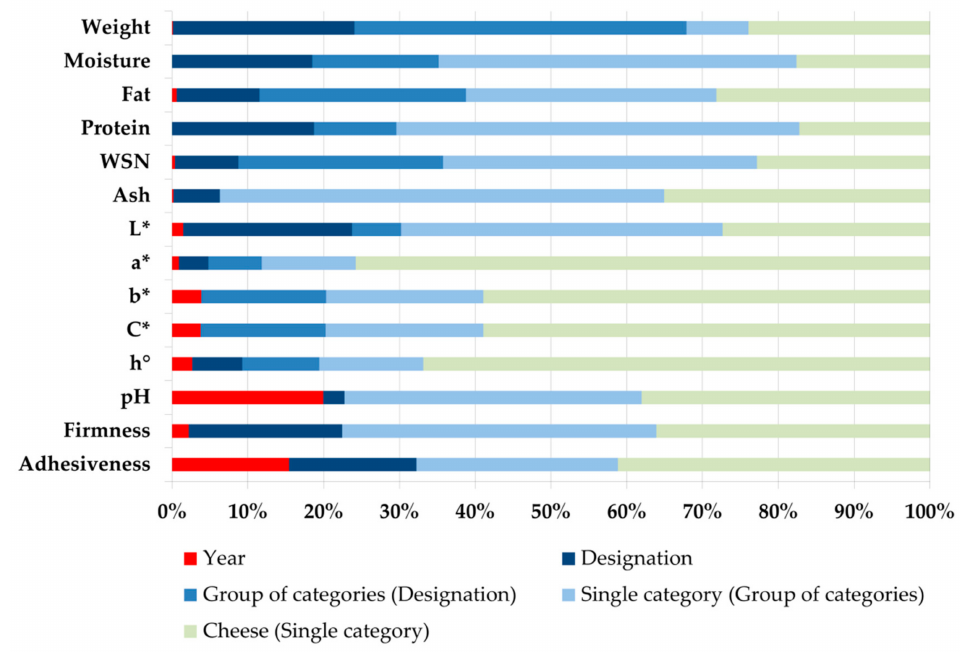
Figure 1. Percentage of total variance of each cheese trait represented by their major sources of varia- tion: the year of sampling, the Designation type (PDO cheeses, Traditional Cheeses, Other cheeses), the Group of categories within Designation (12 groups, see Tables 1 and 2), the Single categories within groups (37 categories), and the individual cheese within category (1050 cheeses